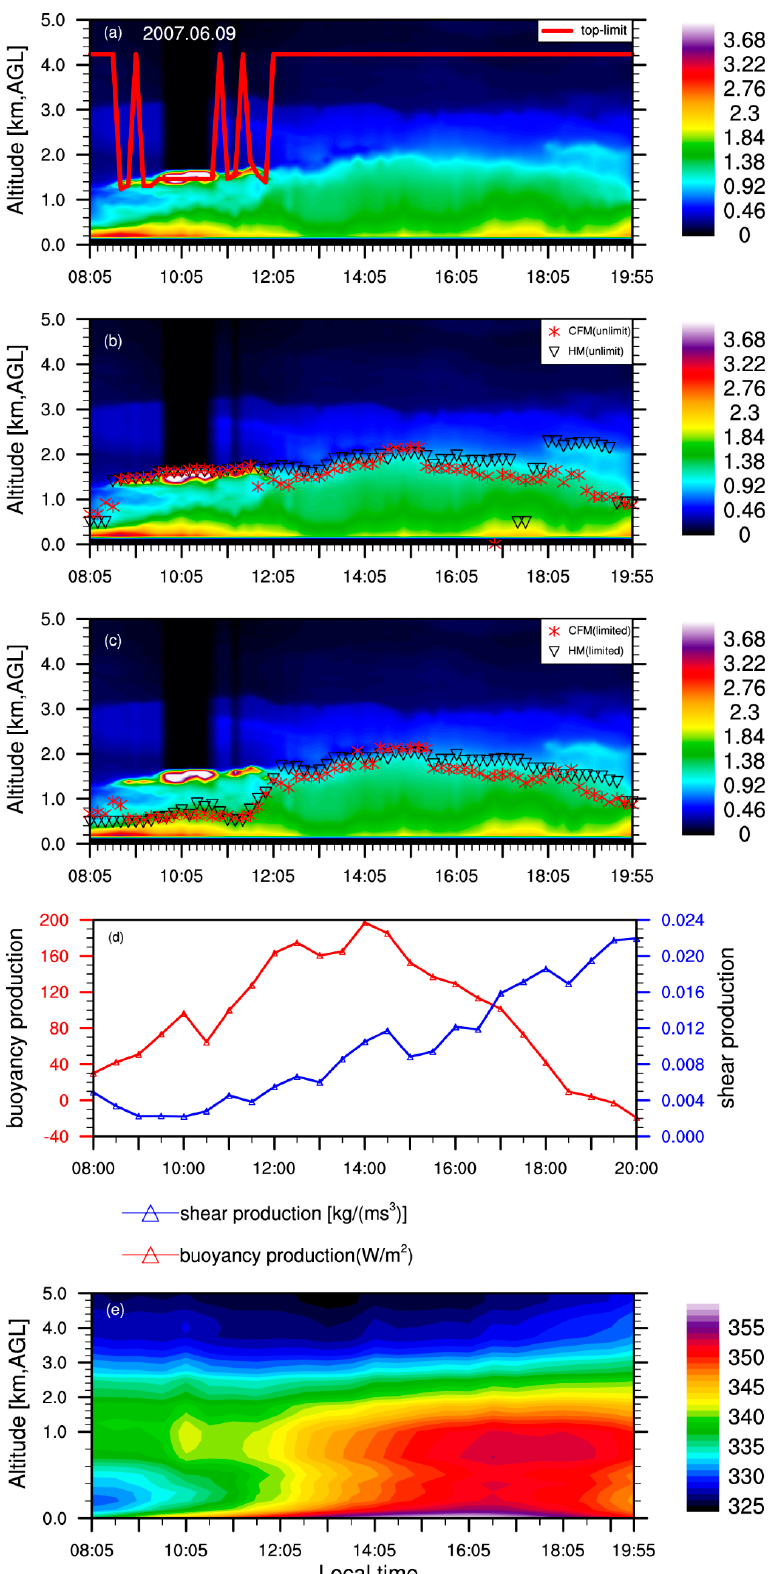
Figure 10. Same as in Figure 9, but on 9 June